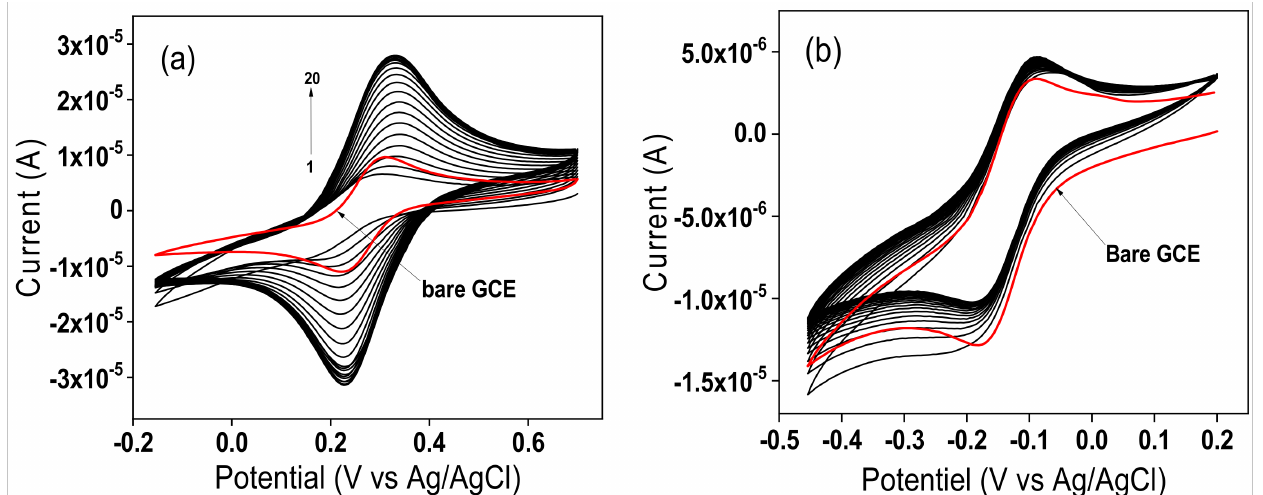
Figure 6. Multisweep cyclic voltammograms recorded in 0.1 M KCl containing ( a ) 1 mM [Fe(CN) 6 ] 3 − and ( b ) 1 mM [Ru(NH 3 ) 6 ] 3+ on TalcNH 2 /GCE. The red curve in ( a , b ) corresponds to the probe signal recorded on the bare GCE, v = 50